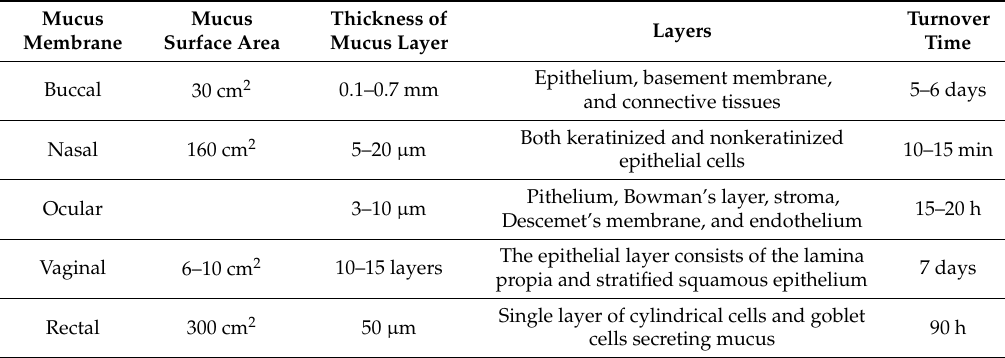
Table 1. Comparison of mucus membranes in different